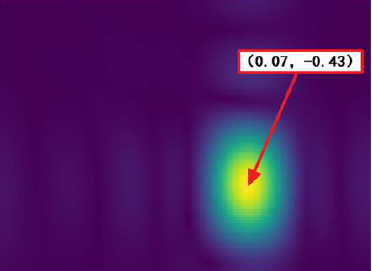
Figure 6. Sound field distribution of the centrifugal pump.